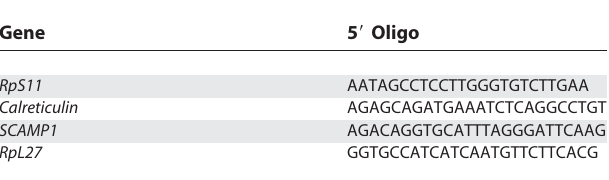
Table 2. Oligonucleotide Sequences for 5 9